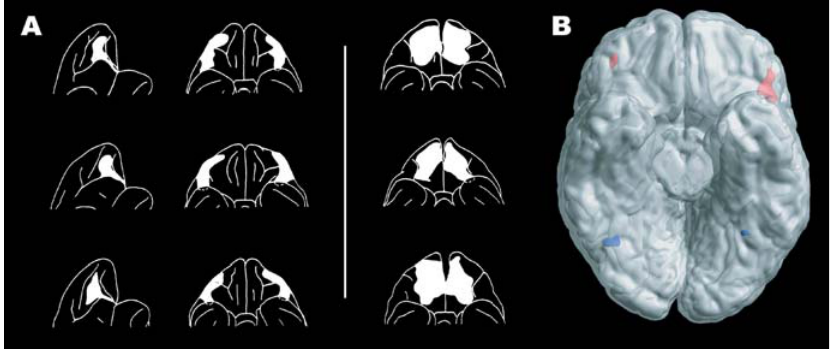
Figure 1. Reversal Learning and the Orbitofrontal Cortex (A) Lateral and ventral views of the surface reconstructions of the lateral and medial orbitofrontal cortex lesions in monkeys (adapted from Iversen and Mishkin 1970), with the former monkeys having diffi culty with the reversal task. (B) A ventral view of the human brain, with the cerebellum removed. Red activations in the lateral orbitofrontal cortex indicate the maximal activation for reversal compared to stable acquisition events. Blue activations indicate the main effects of facial expression (adapted from Kringelbach and Rolls